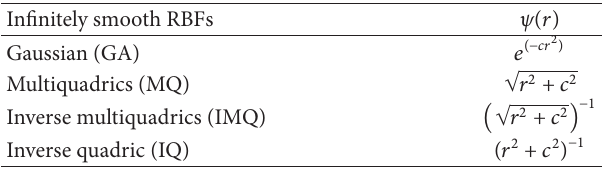
figure out how radial basis functions and the fundamental solutions are applied to approximate the solution of the problem 𝐴 , 2. Similarly, this method will be used for 2 ) −1